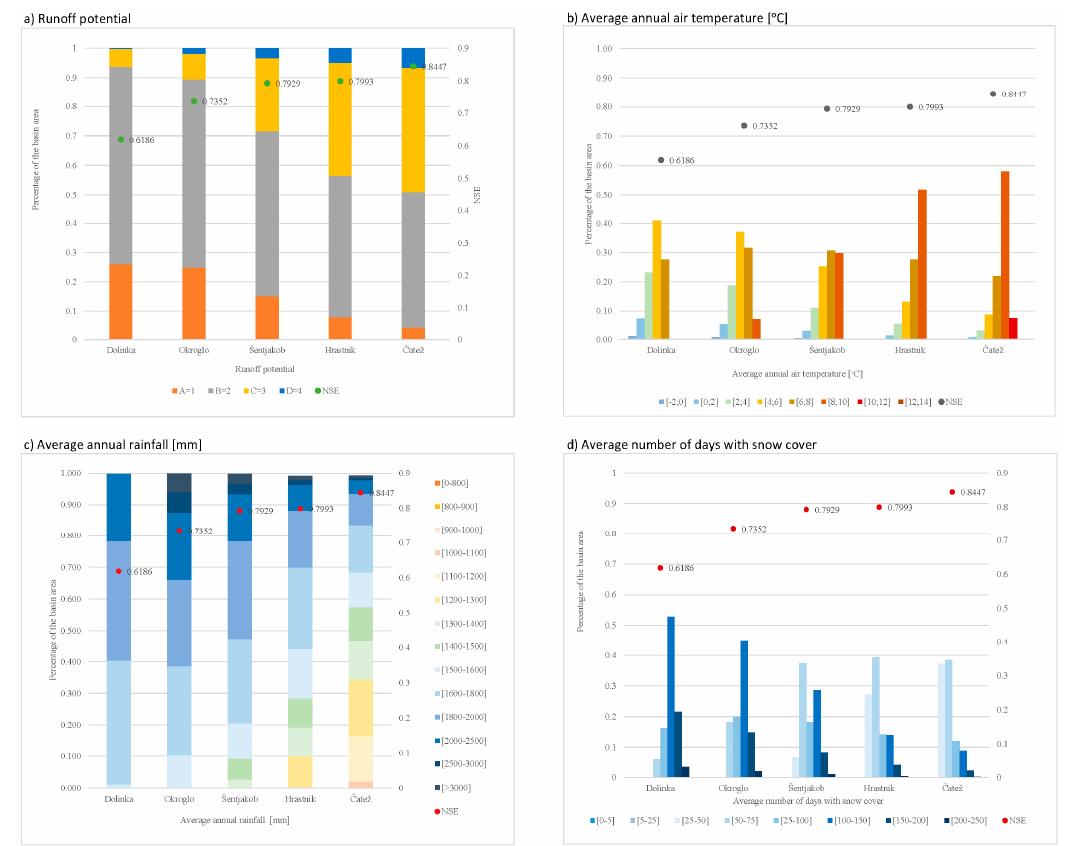
Figure 6. The relationship between runoff potential, average air temperature, average annual rainfall, and average number of days with snow cover and the GR4J model performance (i.e., NSE criteria is used).